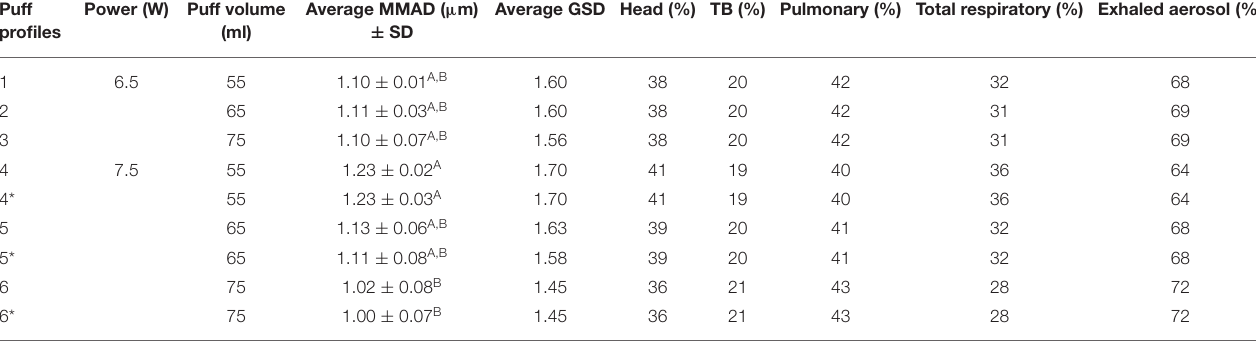
TABLE 2 | Particle size distribution (PSD), regional respiratory deposition, and exhaled aerosol for the reference e-liquid at different puff profiles with three puffs ( n = 3 per profile). Puff Power (W) Puff volume profiles (ml)